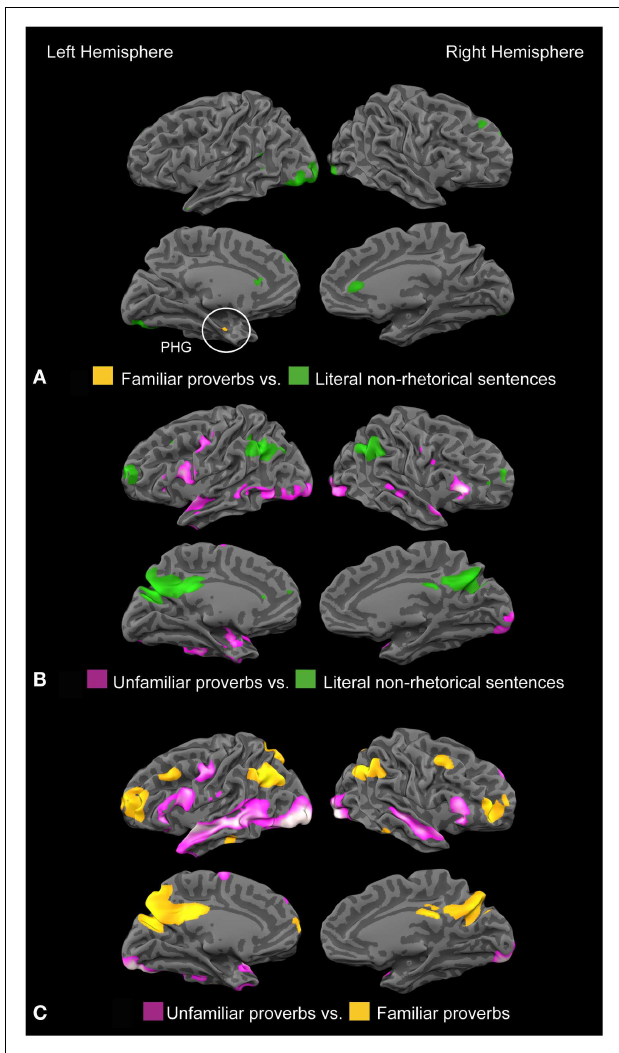
FIGURE 2 | (A) Contrast familiar proverbs – non-rhetorical sentences activate the left parahippocampal gyrus ( X =− 33, Y =− 10, Z =− 17; z = 3.92). (B) Contrast unfamiliar proverbs – non-rhetorical sentences activates a bilateral frontotemporal network. (C) Contrast unfamiliar – familiar proverbs: familiar proverbs elicited a bilateral activation pattern similar to the dorsomedial part of the default network. Unfamiliar proverbs activated areas related to sentence reading, comprising biltaeral MTG/STG (BA 21, 22, 38), bilateral occipital cortex (BA 18/19), posterior rostral part of the medial prefrontal cortex (prMFC, BA 9) and bilateral parts of the motor and premotor cortex (BA